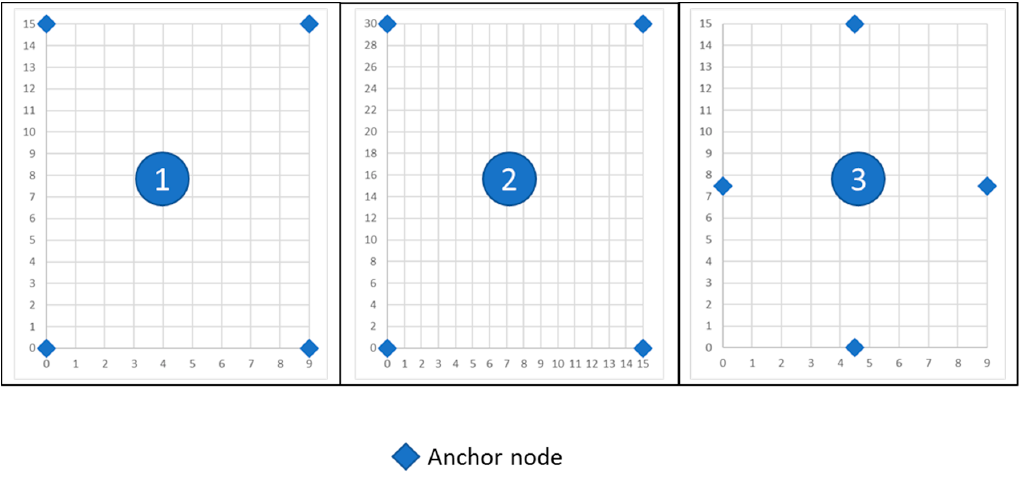
Figure 16. Experimental scenarios.